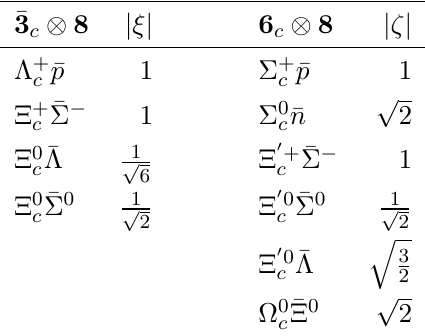
Table 2 . The relations between di(cid:11)erent timelike baryon form factors. The (cid:22) 3 c and 6 c denote the anti-triplet and the sextet charmed baryons, respectively, and the 8 denotes the octet charmless